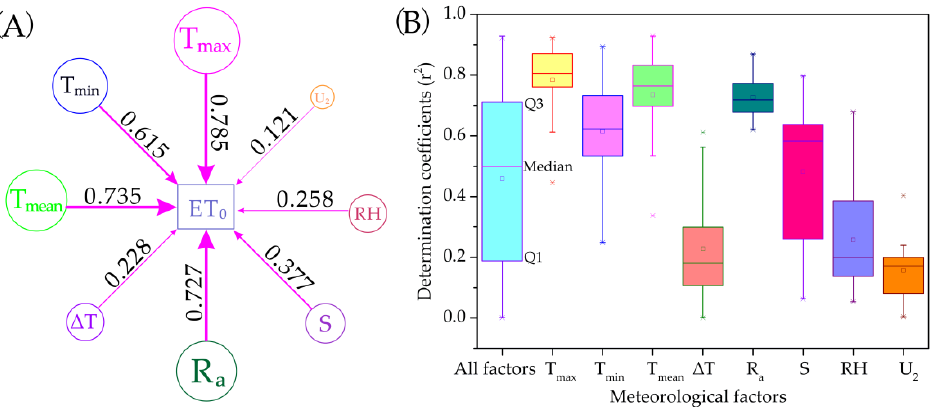
Figure 6. ( A ) Coefficients of determination (r 2 ) between meteorological factors and ET 0 , ( B ) box chart showing the statistical distribution of r 2 for meteorological factors.